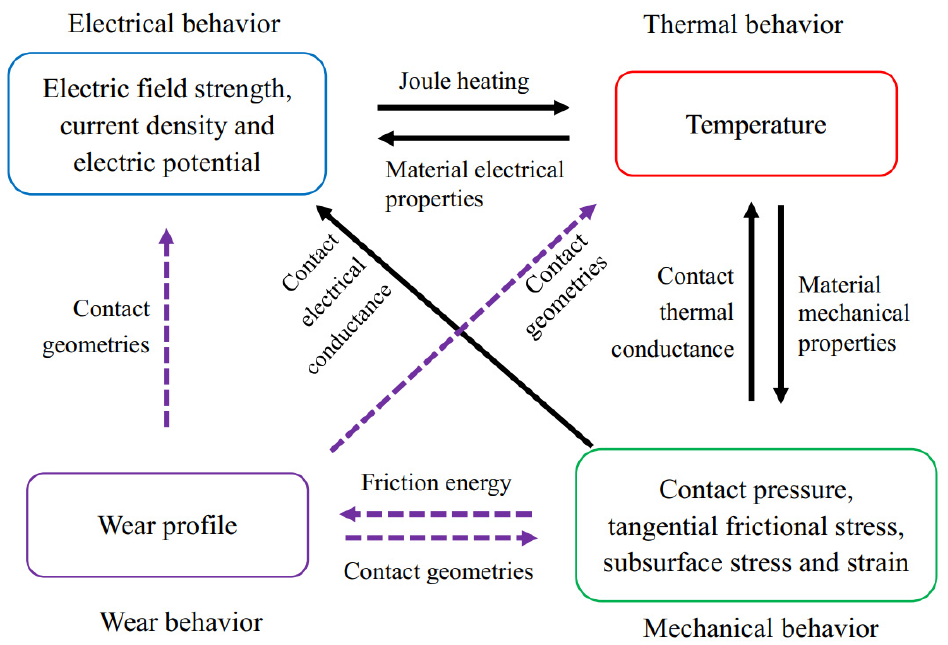
Figure 1. Coupling relationships among electrical, thermal, mechanical, and wear behavior.